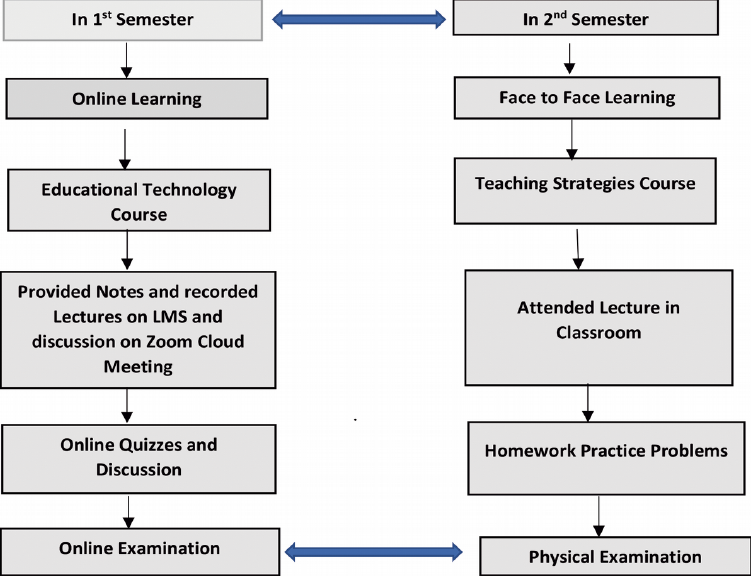
Figure 3. Online and Face to Face Learning Strategies Used in this